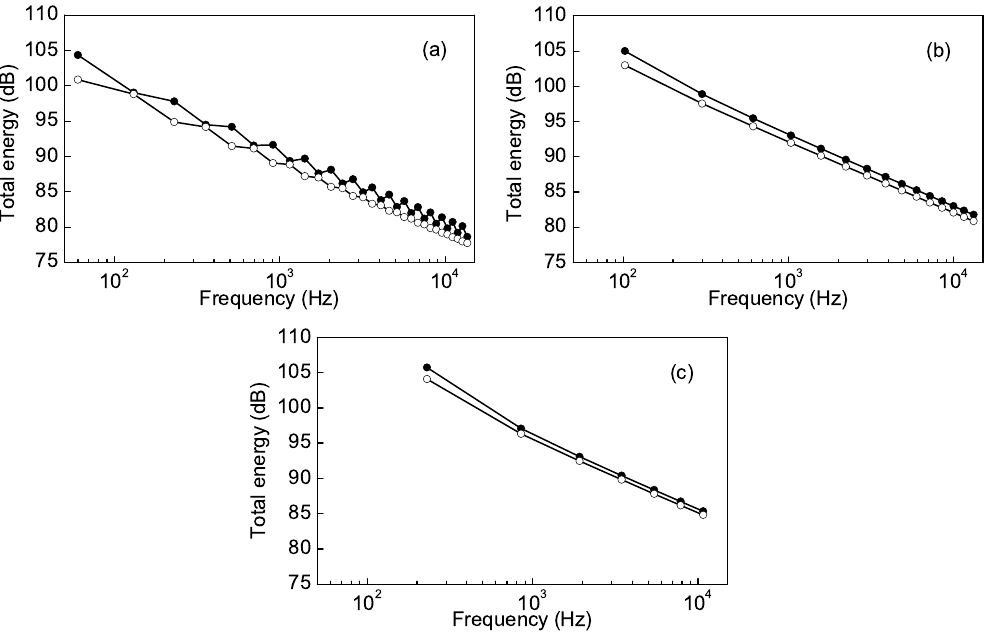
Fig. 7. Total energy response of a beam subject to a concentrated force at the beam center: - • -, exact total energy response; - ◦ -, approximate total energy response. Each frequency band contains: (a) 5 modes; (b) 10 modes; (c) 20 modes. The reference energy is 1 × 10 − 12 J. (3) For distributed excitation, when each frequency band has the same mode count, the estimation error of the total energy response of beam structures using random EFA nearly keeps constant over the whole frequency range, and this also holds for concentrated excitation when each frequency band covers adequate number of